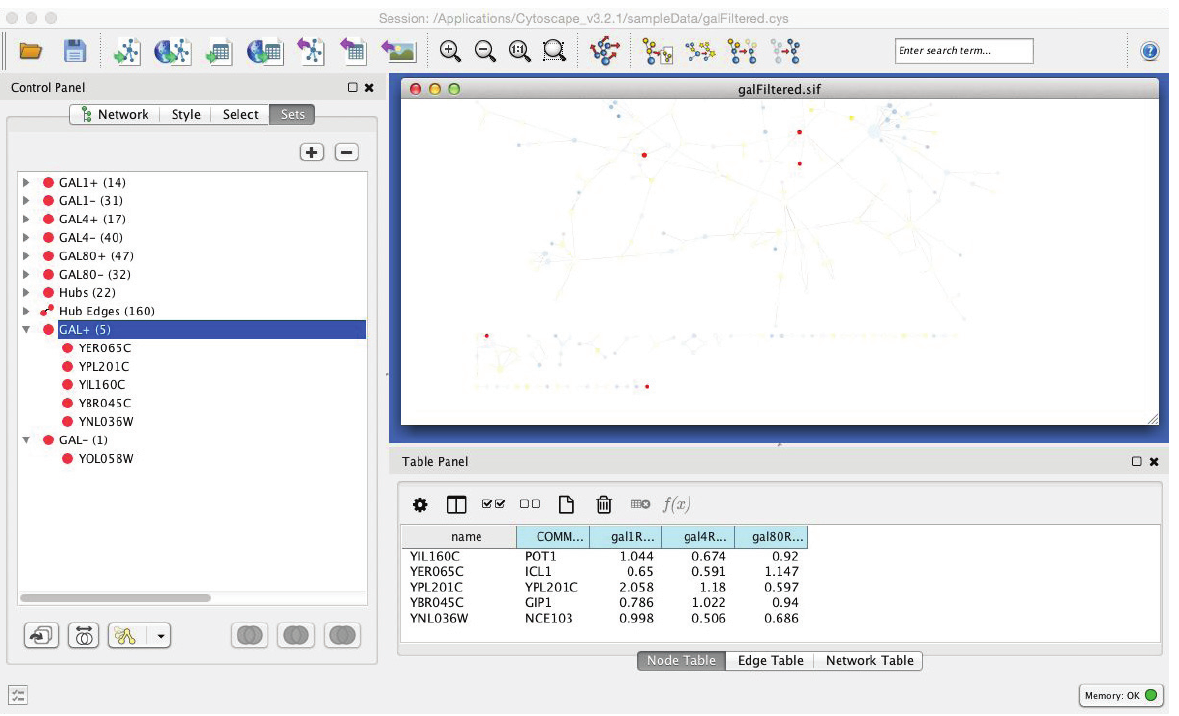
Figure 2. Screenshot of Cytoscape showing the Sets panel with all condition sets created. Nodes in the GAL+ set are highlighted in